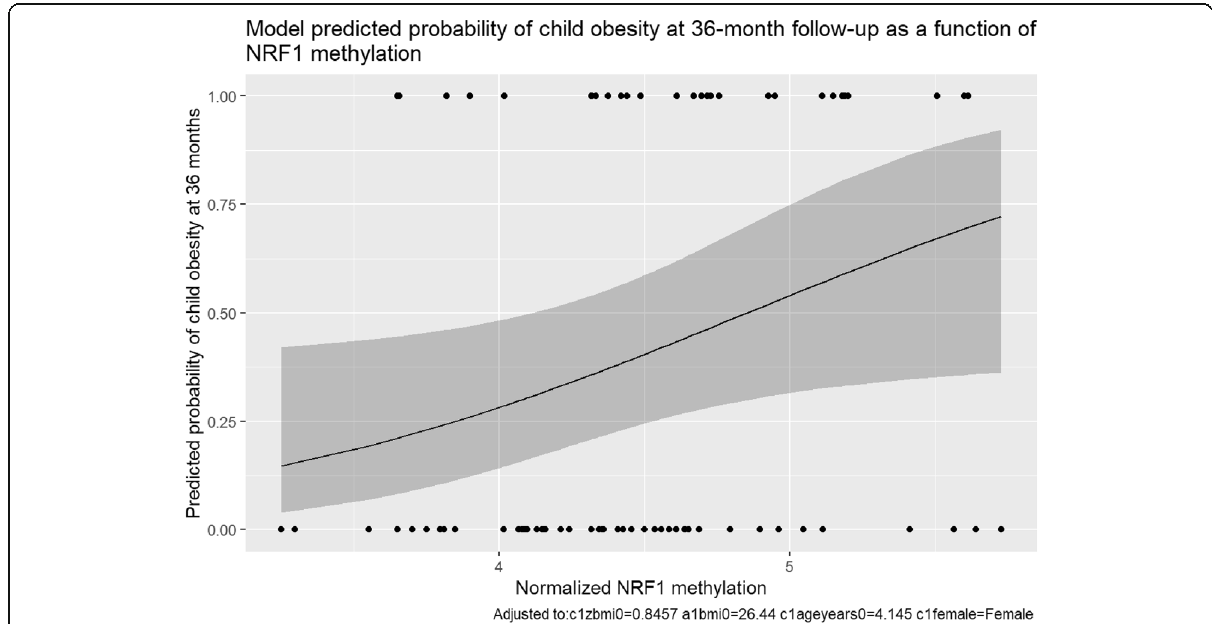
Fig. 1 Model Predicted Probability of Child Obesity at 36-month Follow-up as a Function of NRF1 Methylation. Figure 1 displays the logistic regression model-predicted probability of child obesity at 36 months as a function of the degree of methylation of cg01307483 ( NRF 1). The solid line indicates the predicted probability, and the gray shaded region represents the 95% confidence interval. As the degree of methylation of NRF1 increases, the probability of child obesity at 36 months increases significantly